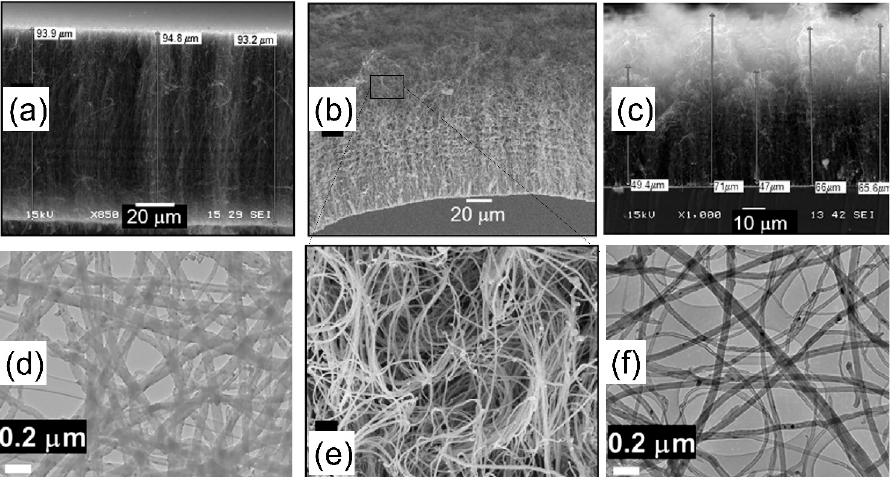
Figure 5. SEM micrographs of CNT carpets on ( a ) α -Ta(N) at 0.28 N/Ta at.%; ( b ) Ta 2 N at 1.2 N/Ta at.%; and ( c ) Ta 5 N 6 at 1.65 N/Ta at.%. ( d , f ) are the TEM micrographs from CNT recovered from the sample presented in ( a , c ), respectively; ( e ) is the SEM magnification of a top part from the CNT carpet presented in ( b ) All CNT carpets were produced via AACCVD at 850 °C by using ferrocene in toluene as carbon precursor. Reproduced with permission from Bouchet-Fabre, Diamond and Related Materials; Ref. [77] copyright 2011, Elsevier.